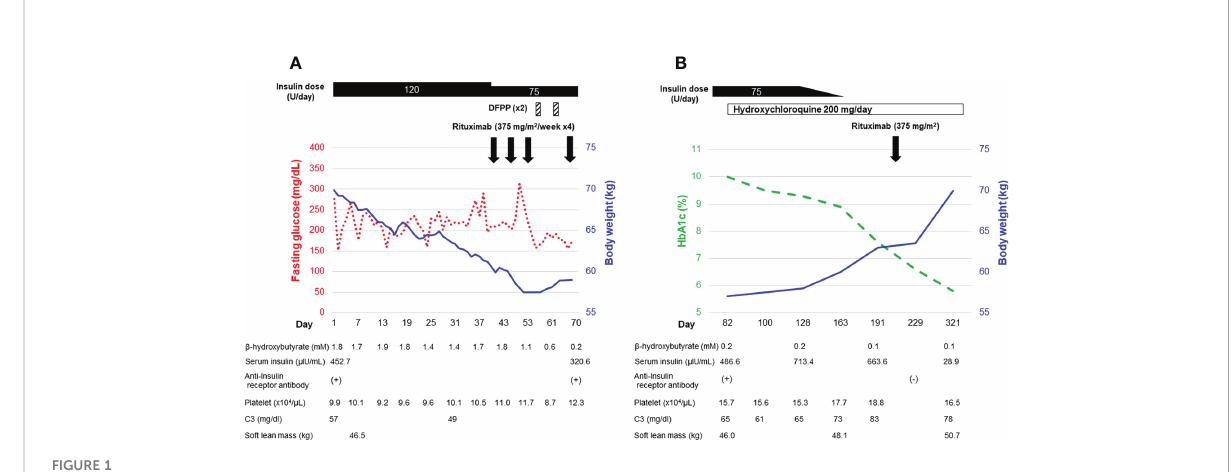
FIGURE 1 Clinical course of the patient during hospitalization (A) and in the outpatient setting (B)